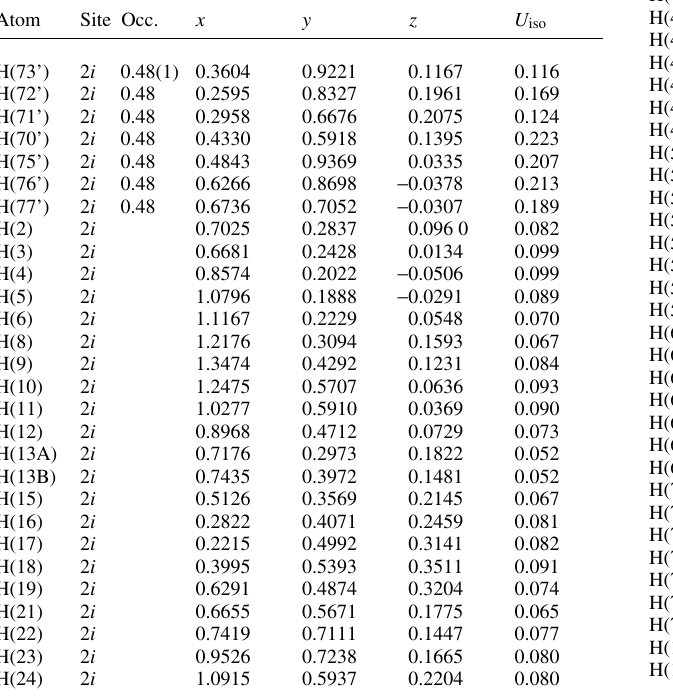
Table 2. Atomic coordinates and displacement parameters (in Å 2 ) .